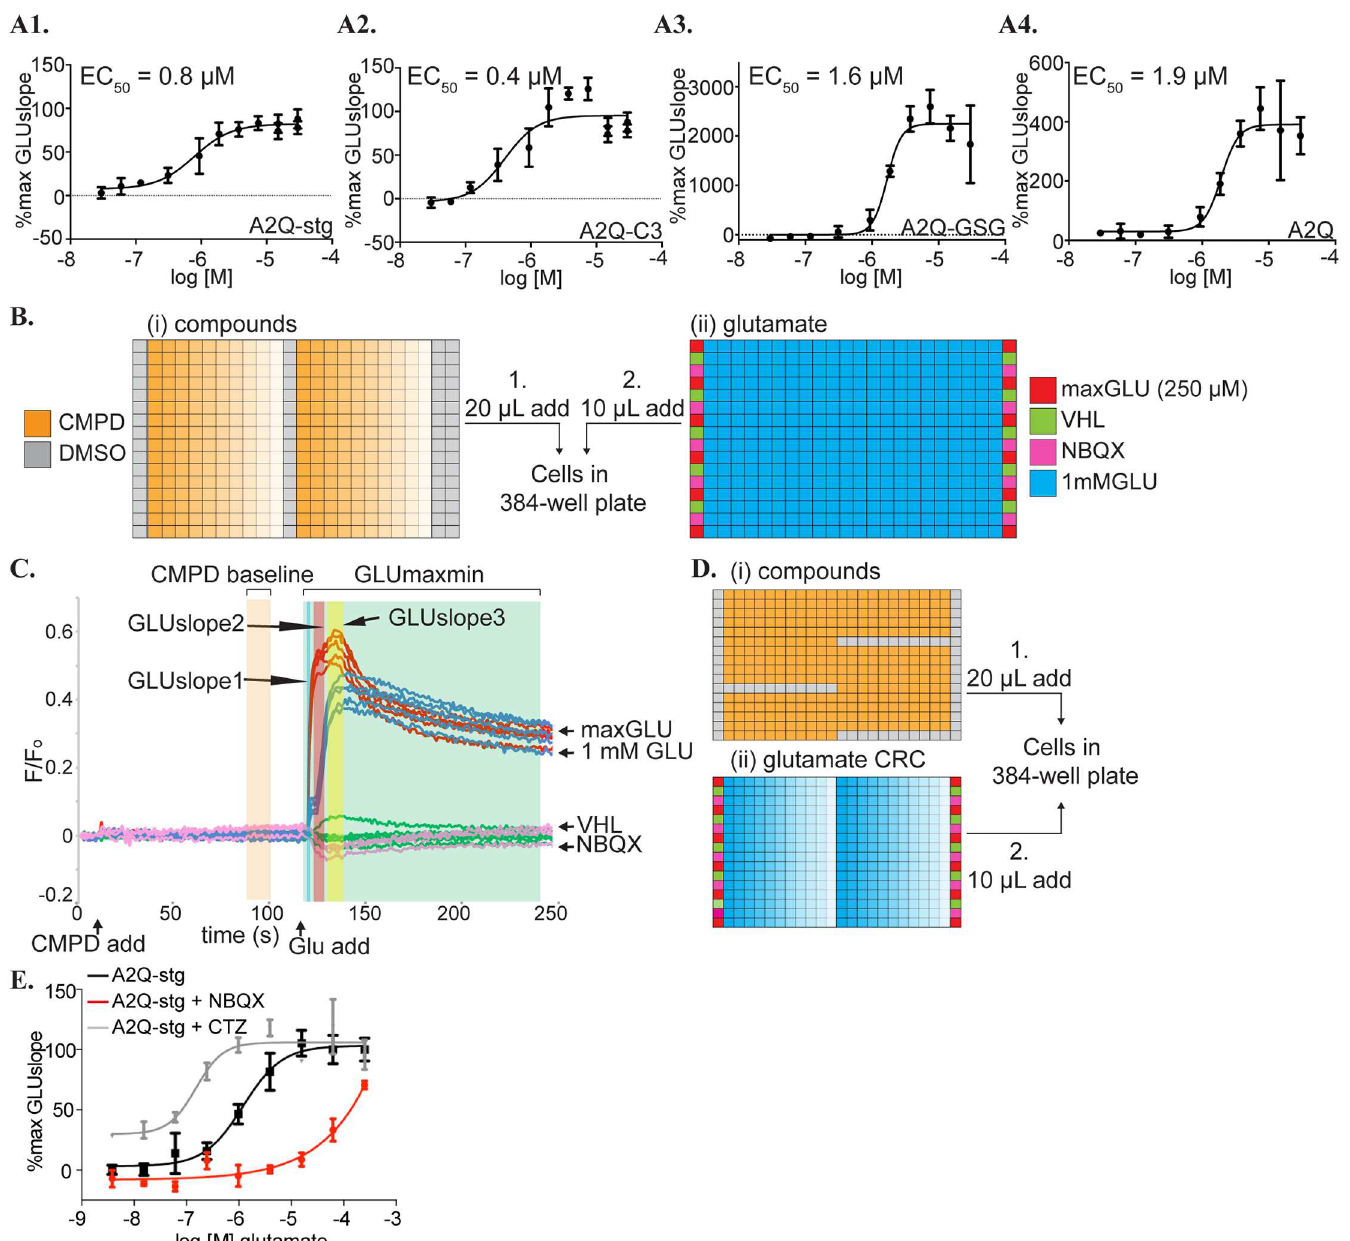
Fig 4. Controls and experimental setup for calcium flux assays.(A) CRC curves for CTZ in the presenceof 1 mM glutamatefrom (1) A2Q-stg, (2) A2Q-C3, (3) A2-GSG, (4) A2Q cell lines in the calciumflux assay. These CRCs are calculatedfrom the GLUslope1 (t = 122-125s) window. CalculatedEC 50 values are includedin the top left of the graph. %max GLUslope= (GLUslope–mean VHLslope)/ (mean maxGLUslope–mean VHLslope)as describedin methods. (B) Compound and glutamateplates addedto cells by the FDSS in our Fluo-8 calciumflux compoundCRC assay. (i) Compounds(orange) are added as a 30 μ M– 30 nM CRC (decreasingcolor saturation). (ii) Controls to determinea Z’ for each plate line the edgesof the glutamateplates. Positive control = 250 μ M glutamate(maxGLU, red), high calcium buffer vehicle(VHL, green), and negativecontrol = 30 μ M NBQX (NBQX, pink). 1 mM glutamateis added across the plate (blue) with columns 12 and 23 used as a 1mM glutamateand DMSO control. (C) Vehicle subtracted, normalized fluorescence data readout for the FDSS on A2Q-stg cells in a calcium flux experiment showingthe compound and glutamateapplicationsat 10s and 120s, respectively. Controls are shown in colors corresponding to their colors in the glutamateplate in (D). Different hit windowsare shaded in blue (GLUslope1, 122-125s),red (GLUslope2, 126-132s),yellow (GLUslope3, 140-150s),green (GLUmaxmin). The orangewindowis a reference baseline(CMPD baseline)prior to the glutamateadditionused to determineif the compoundshows activity in the absenceof glutamate. (D) Compoundand glutamateplates added to cells by the FDSS in our Fluo-8-based glutamatepotency fold-shift assay. (i) Compounds (orange)are first added at 30 μ M with DMSO controls in columns 1,24, and also in K1-K12, F13-23, P13-23, overlappingwith glutamateconcentration curves for a per plate comparisonto compound. (ii) Controls are loadedon the edge as in (Bii) and a glutamateCRC is loadedhorizontallyrangingfrom 4 mM to 10 pM (decreasingcolor saturation). (E) An exampleof the readout for our